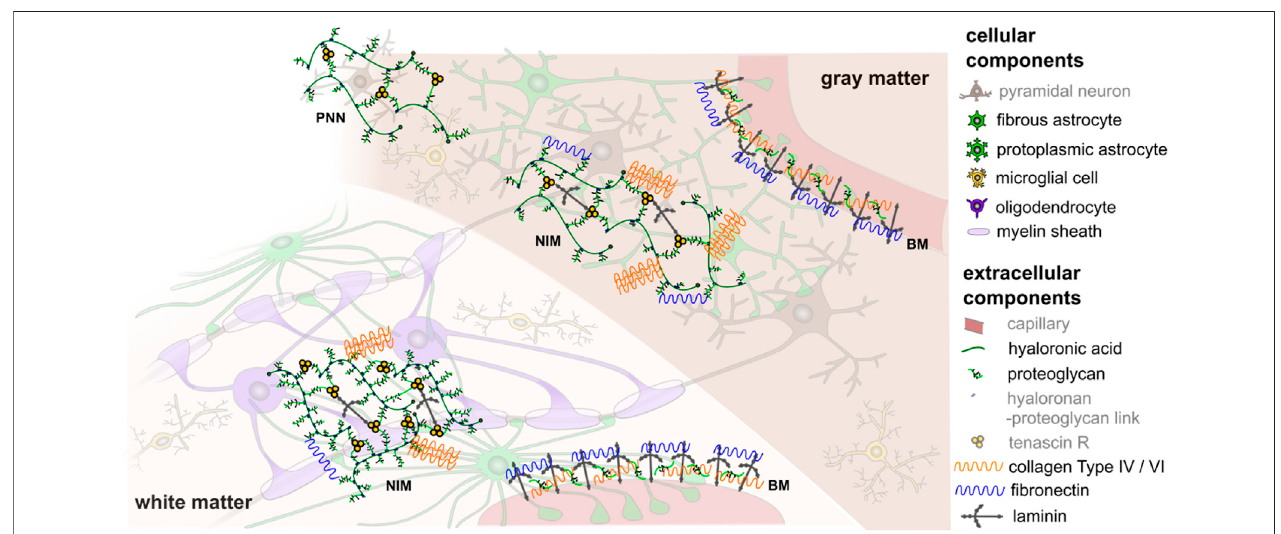
FIGURE 2 | Schematic illustration of the cellular and extracellular components of human brain tissue (components greyed out are not further considered in the present work). White matter contains oligodendrocytes, which wrap myelin sheath around axons, as well as fi brous astrocytes and microglia. Gray matter contains mainly neurons, protoplasmic astrocytes, and microglia. The extracellular matrix has three principal compartments: the basement membrane (BM), which lines cerebral microvesselsandthepialsurface,theneuralinterstitialmatrix(NIM),whichisdiffuselydistributedinthebrain ’ sinterstitialspace,andperineuronalnets(PNN),which surround inhibitory interneurons in certain areas of gray matter. In different compositions, these compartments contain proteoglycans, hyaluronic acid, link proteins, glycoproteins(e.g.,tenascin,laminin, fi bronectin),andnon- fi brillarcollagenstypeIVandVI(Lauetal.,2013).Thisisaschematic fi gureforidenti fi cationpurposesonlywith no claim of being complete or true to scale. Reprinted from Budday et al. (2020b) with permission from